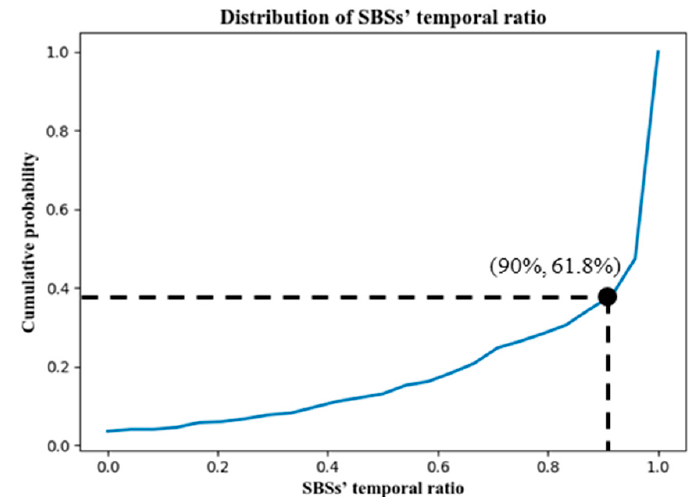
Figure 11. The cumulative distribution function (CDF) of SBSs’ temporal ratio.